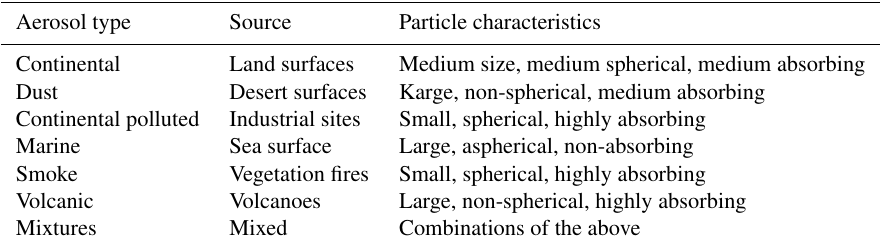
Table 1. Conventional names of the aerosol types.